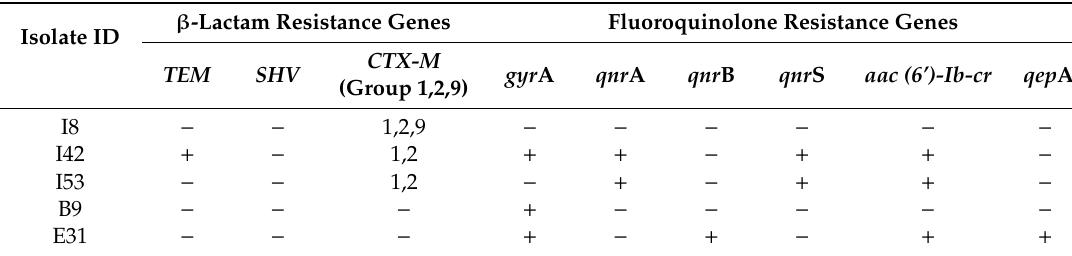
Table 1. Resistance (ESBL and Fluoroquinolone) Genes Detected in E. coli.